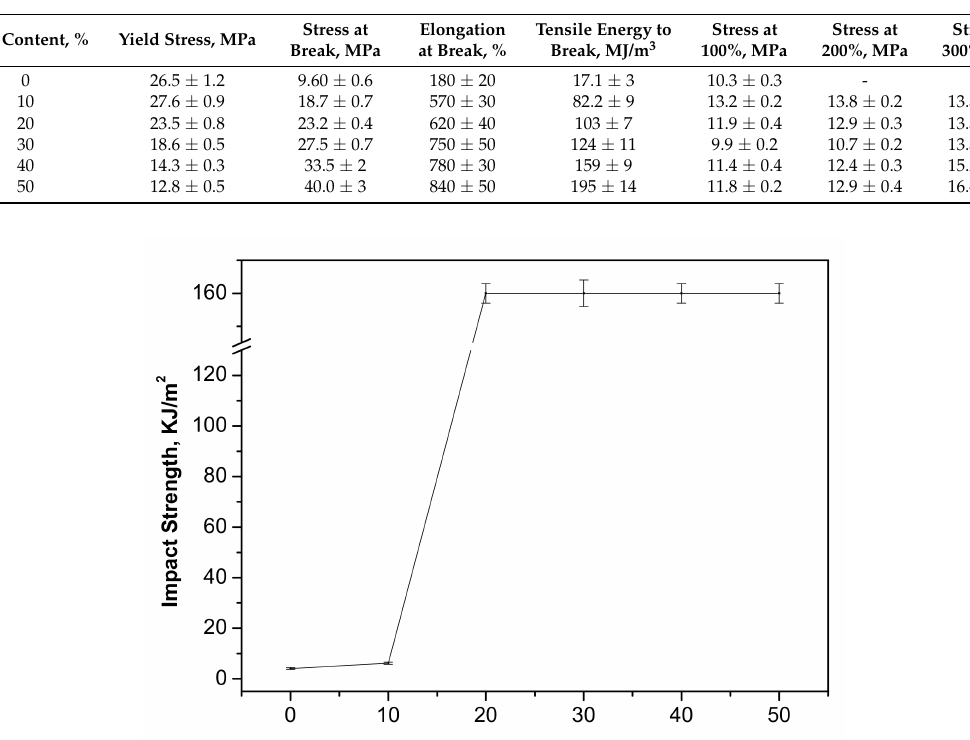
Table 1. Mechanical property of PPC/TPU blends with different TPU contents.